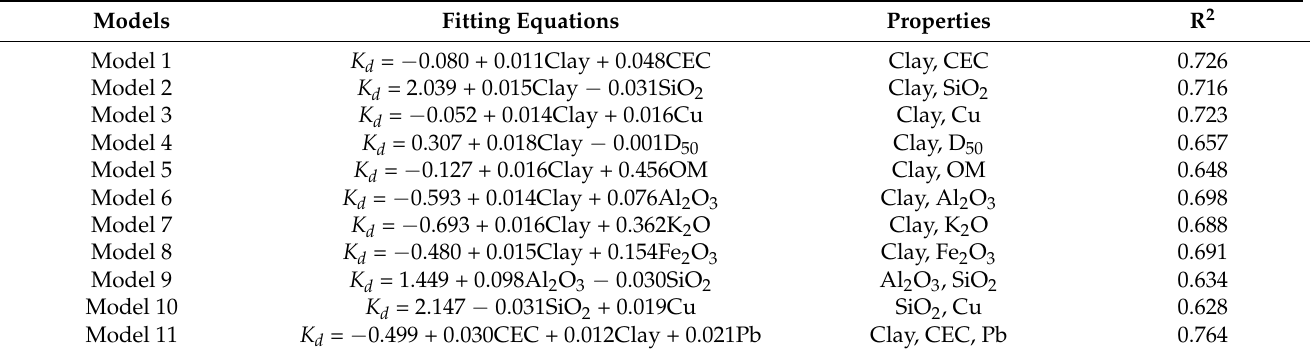
Table 4. Prediction models of TC adsorbed on estuary and marine